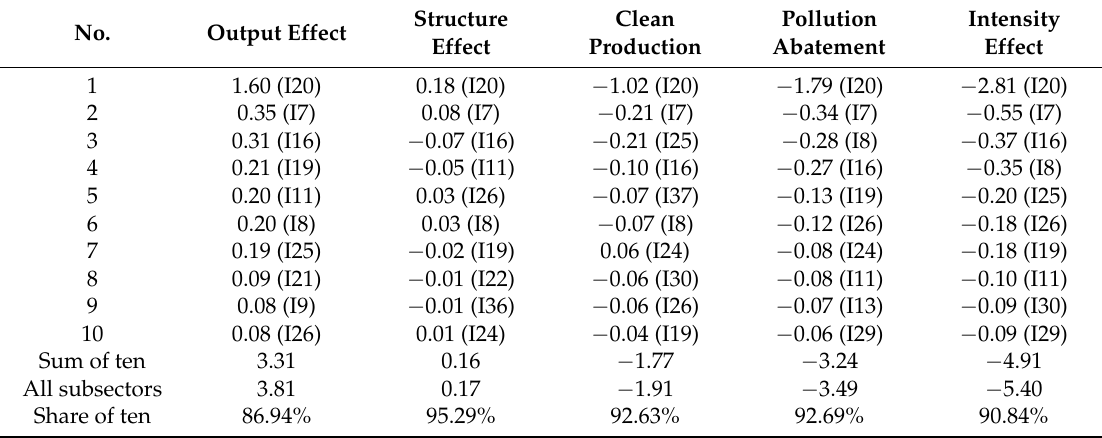
Table 4. The top ten sub-sectors contributing to NH 3 -N discharge by their different effects (10 4 t).